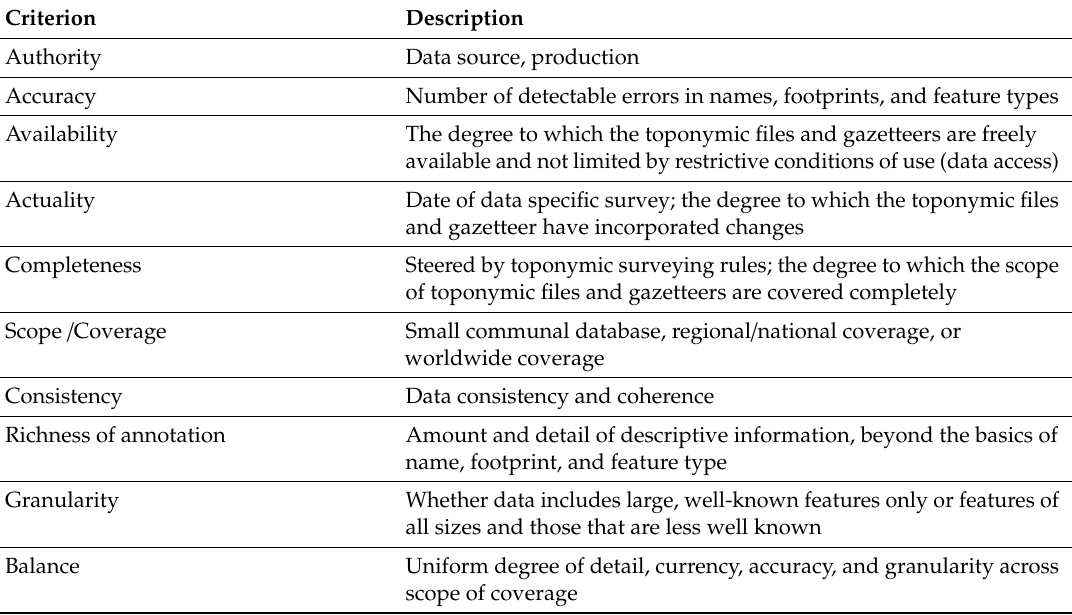
Table 1. Verification criteria for toponymic files and